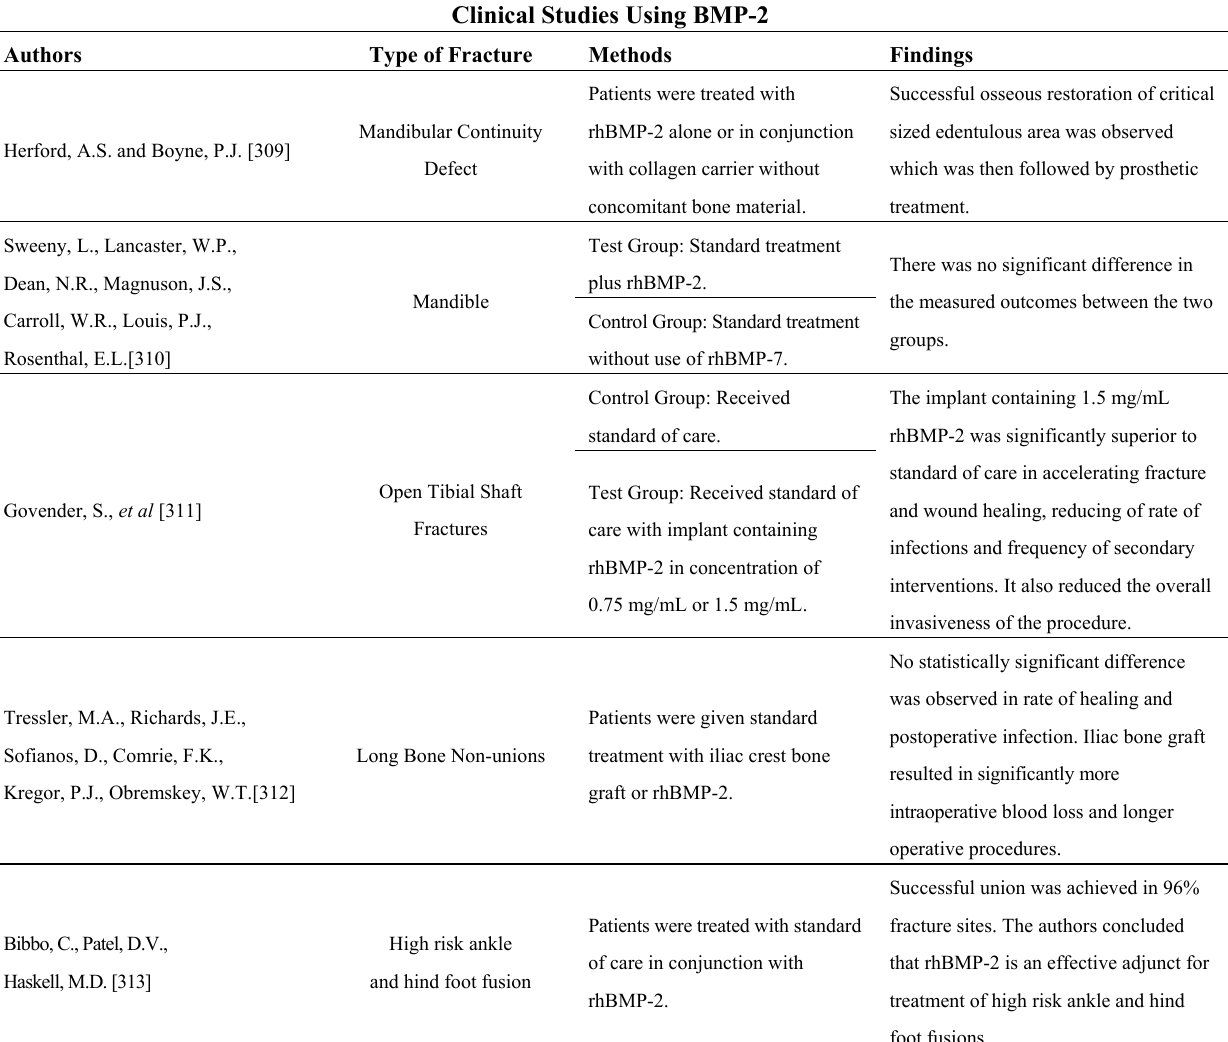
Table 3. Clinical studies carried out using BMPs for bone tissue